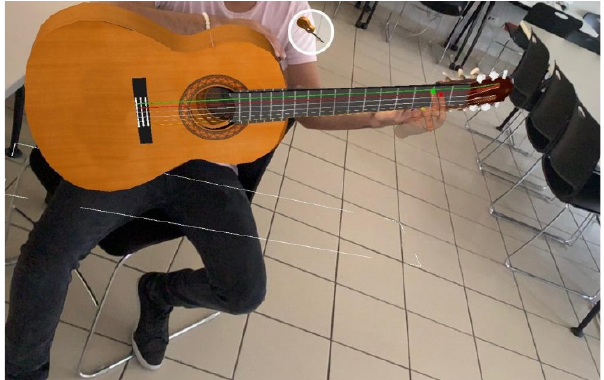
Figure 4. Example of task: Student performing the G chord.